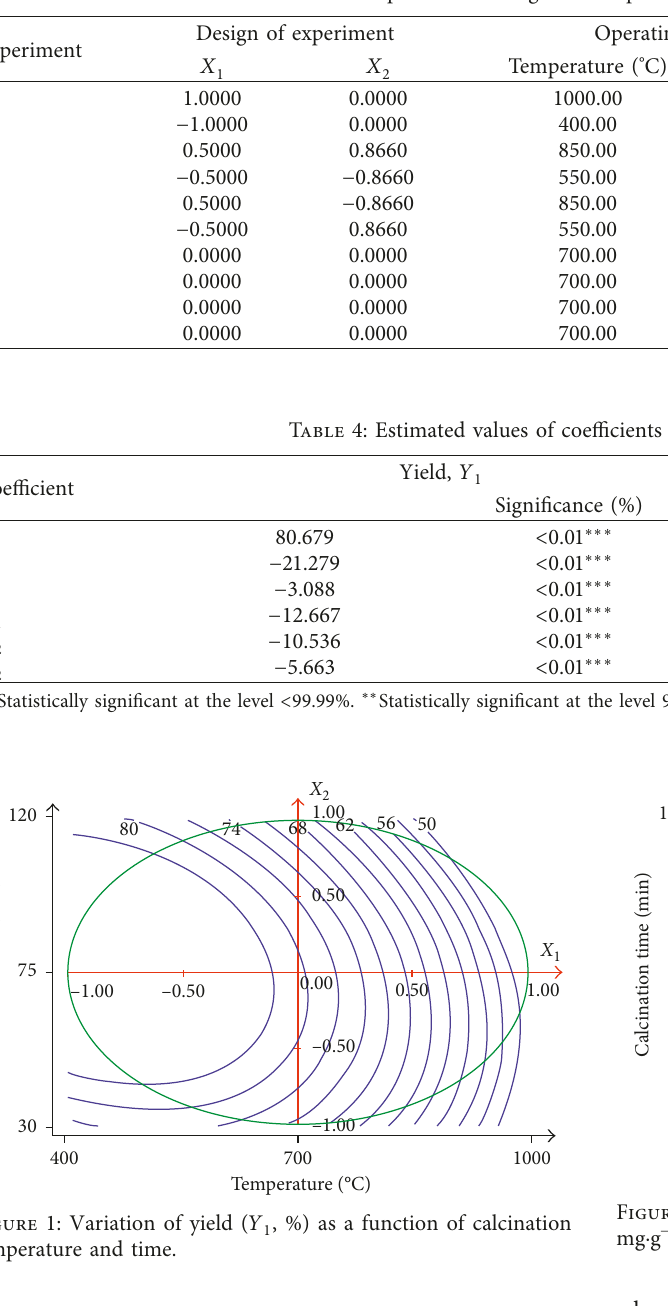
Table 3: Doehlert’s experimental design and responses: Y